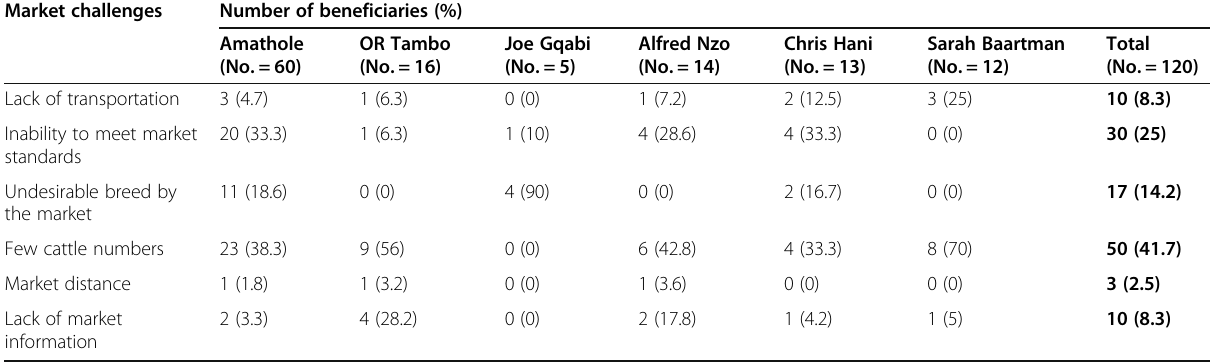
Table 7 Perceived market challenges faced by the beneficiaries of the Nguni Cattle Project in Eastern Cape Market challenges Number of beneficiaries